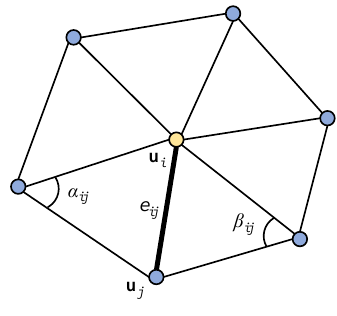
Figure 1. The vertex i and its one-ring neighborhood vertices N ( i ) are represented as yellow and blue points. The edge between the vertices i and j is denoted by e ij , and two opposite angles of e ij are defined as α ij and β ij